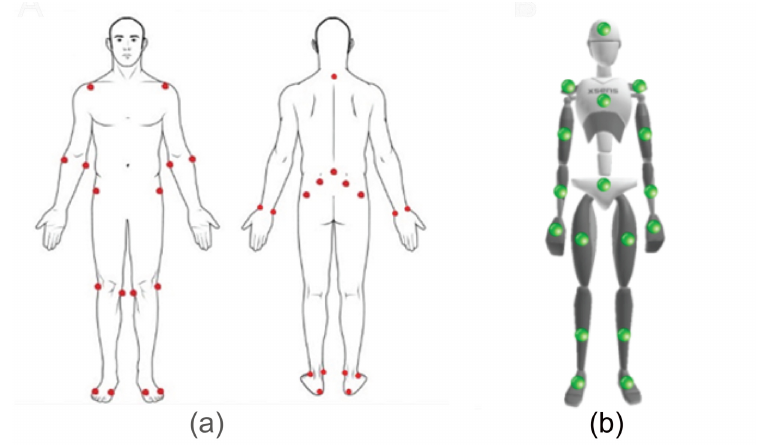
Figure 3. An illustration of the location of the markers. ( a ) Reflective markers for optical motion capture; ( b ) Xsens IMU